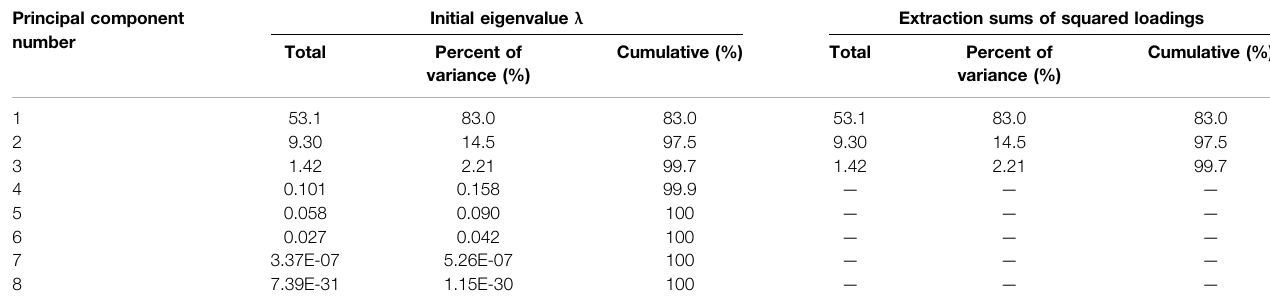
TABLE 4 | Total PCA variance of heavy metal contents in soil